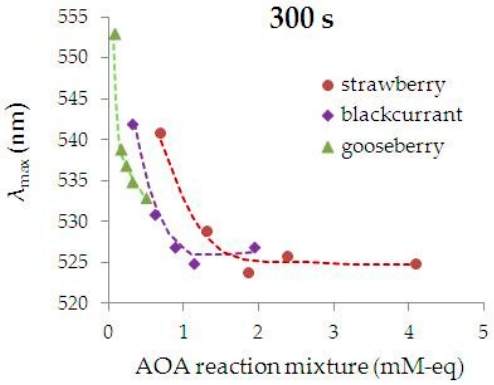
Figure 7. Dependence of the phyto-AuNPs’ suspension absorption maximum wavelength ( λ max ) on the AOA of the reaction mixtures containing leaf extracts from gooseberry, blackcurrant, and strawberry. (Synthesis conditions: 5 mL of 1 mM HAuCl 4 + 1 mL of extract, time 300 s).